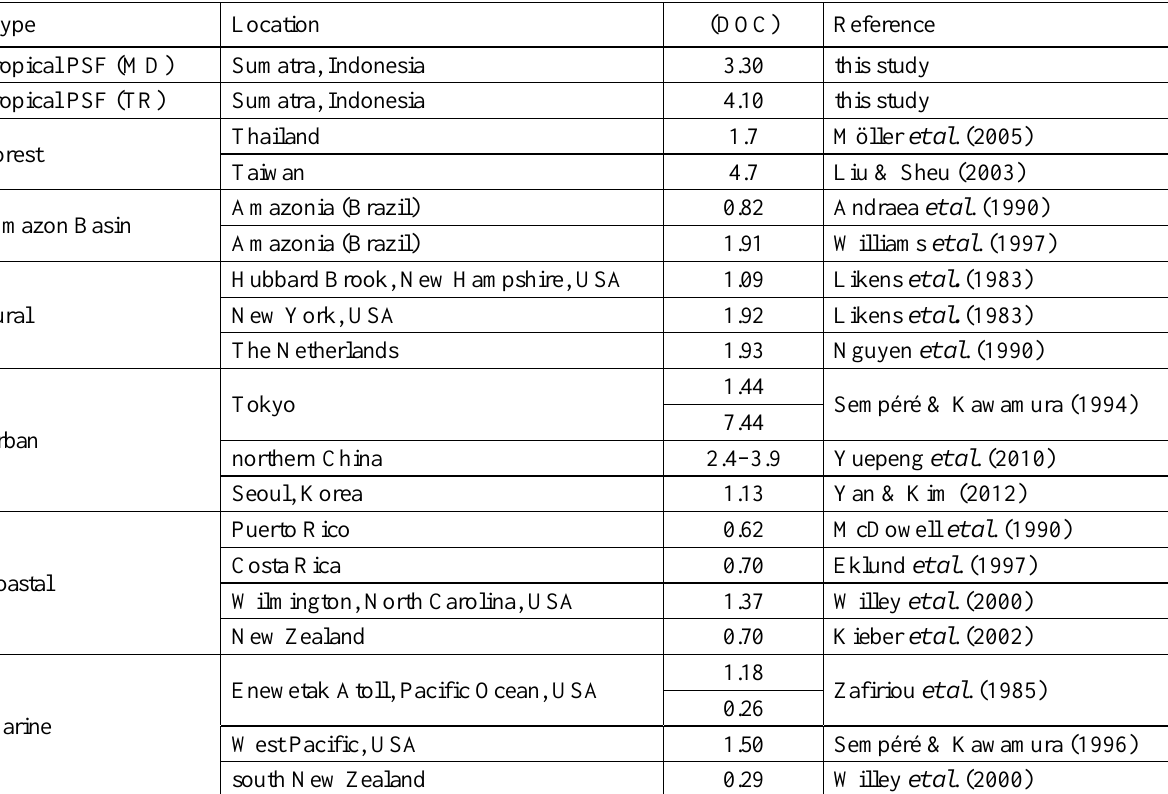
Table 4. DOC concentrations ((DOC), mg C L -1 ) in the rainwater of areas with different land uses/locations.